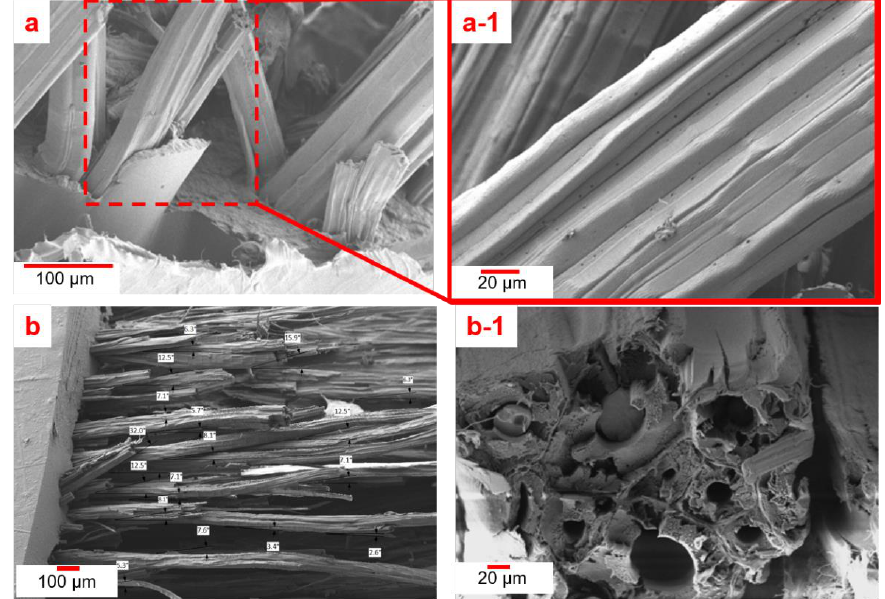
Figure 7. Images of ( a ) pulled-out kenaf fibers and ( a1 ) smooth kenaf-fiber surface, ( b ) kenaf / PP composite at orientation angle of 90 ◦ , and ( b1 ) kenaf / PP composite at orientation angle of 90 ◦